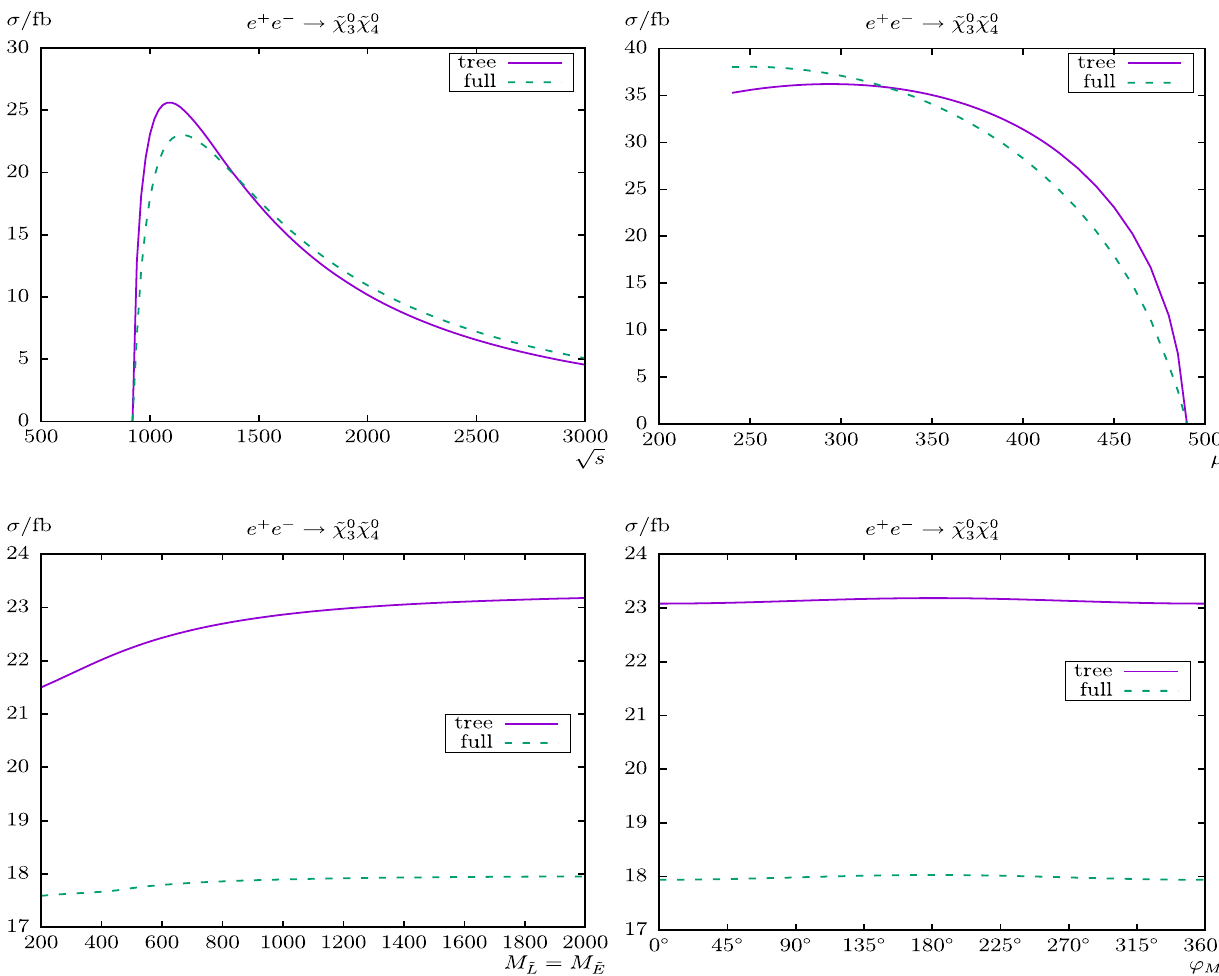
˜ χ 0 ) . Tree-level and full one-loop corrected cross sections are shown with parameters chosen according to S ; see Table 2. √ 3 4 s (left) and μ (right) varied; the lower plots show M ˜